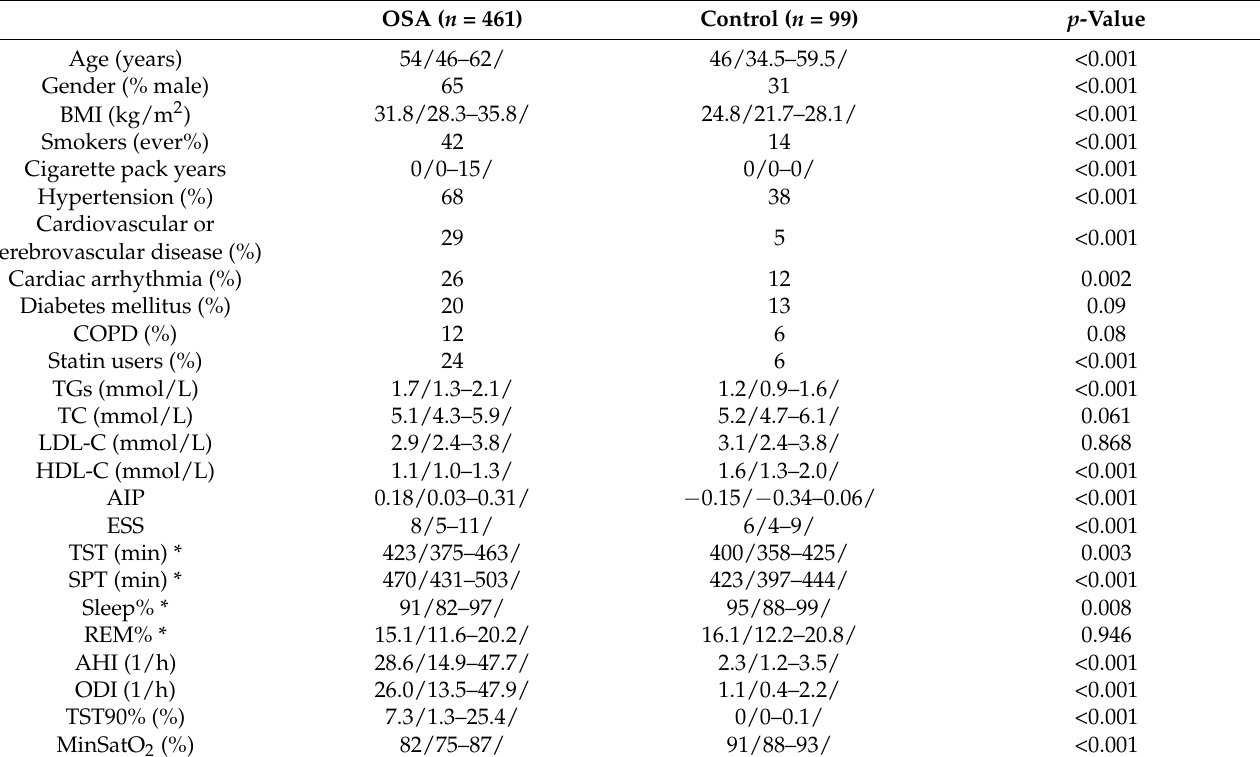
Table 1. Comparison of OSA and control groups—demographic, anthropometric, clinical and sleep characteristics.